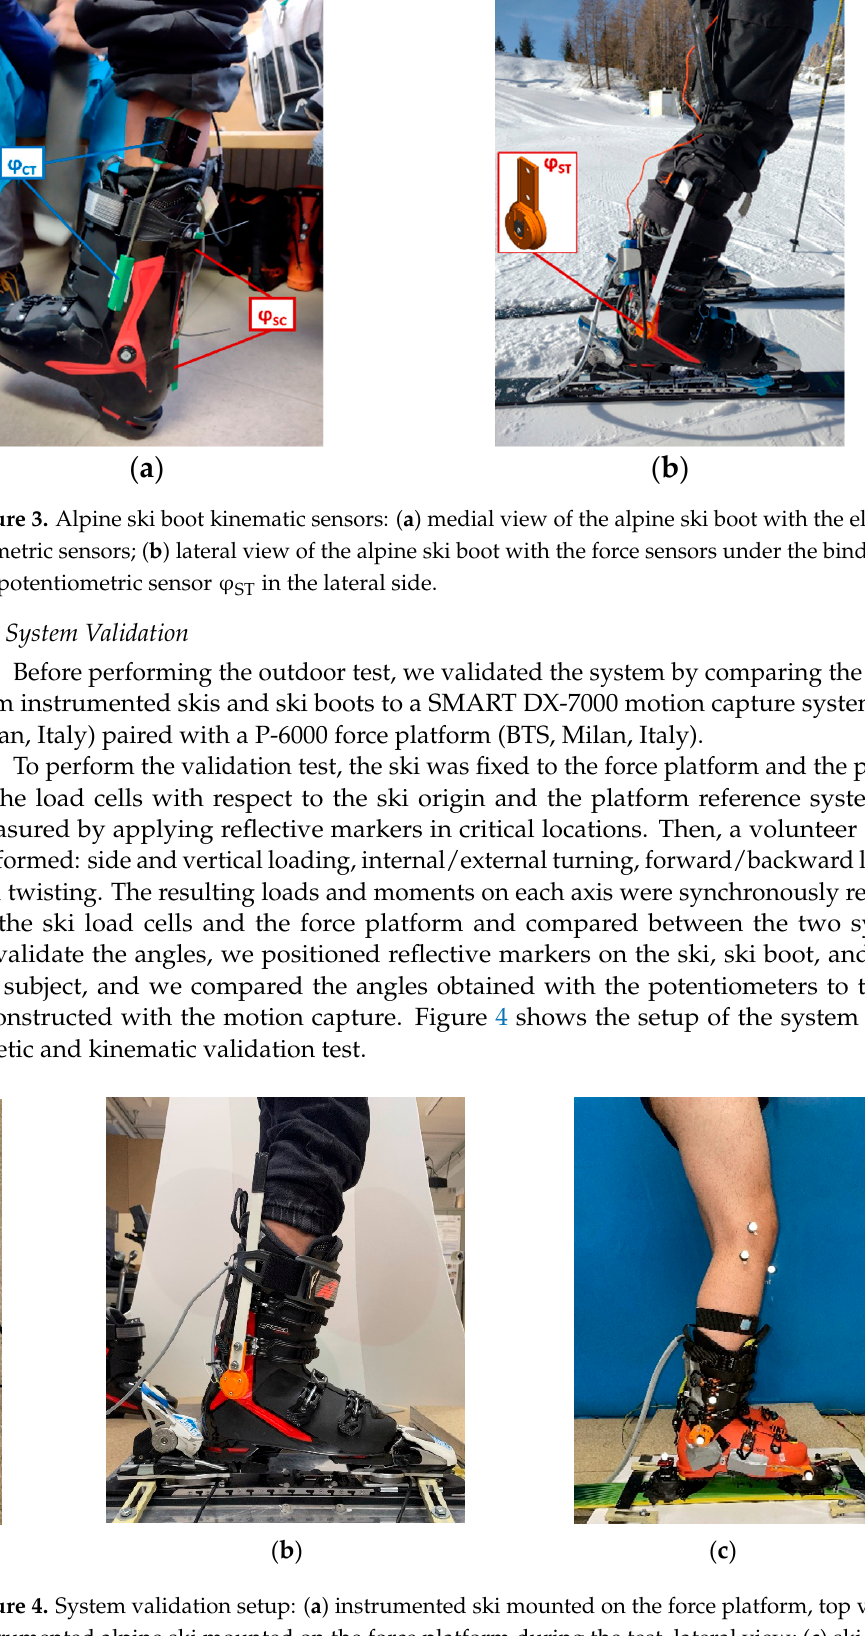
Figure 4. System validation setup: ( a ) instrumented ski mounted on the force platform, top view; ( b ) instrumented alpine ski mounted on the force platform during the test, lateral view; ( c ) ski tour- ing boot with markers for angular sensors validation.